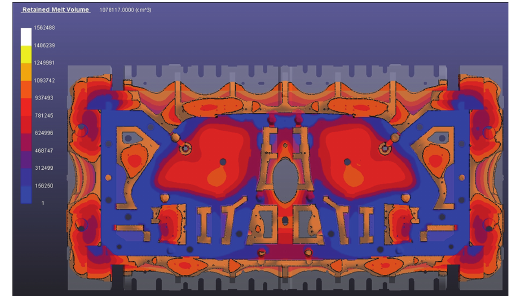
Figure 15: The retained melt volume criterion.